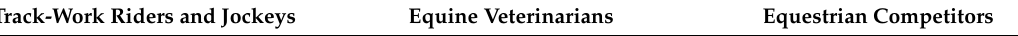
Table 1. Examples from track-work riders and jockeys, equine veterinarians and equestrian competitors that illustrate the relevance of context and purposeful effective strategies that can increase the risk of